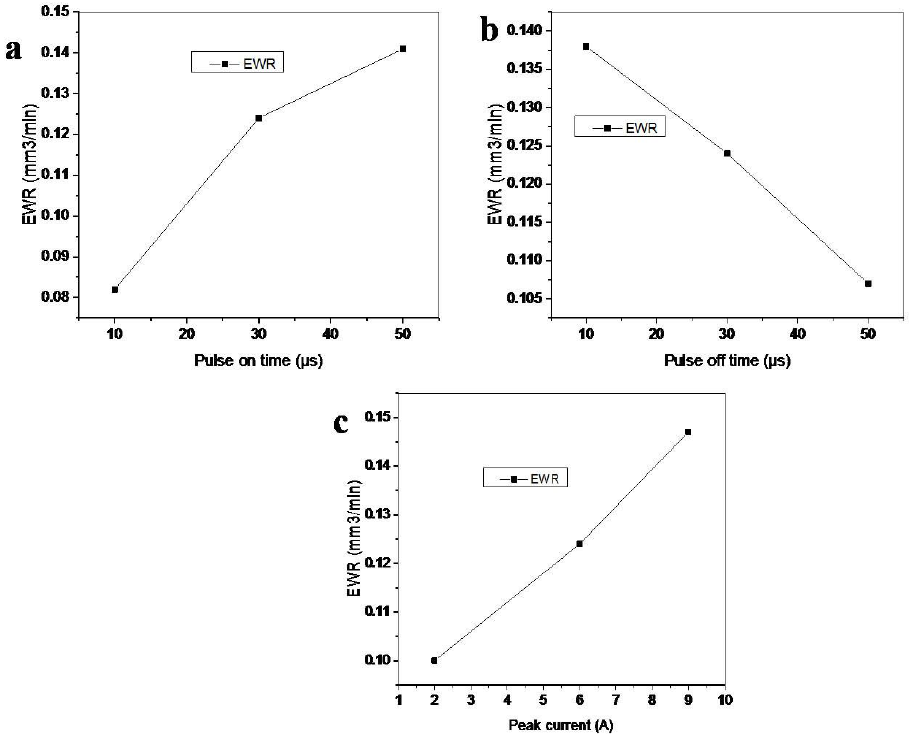
Figure 5: Main effect Plots for EWR (a) Ton Vs EWR; (b) Toff Vs EWR; (c) Ip Vs EWR